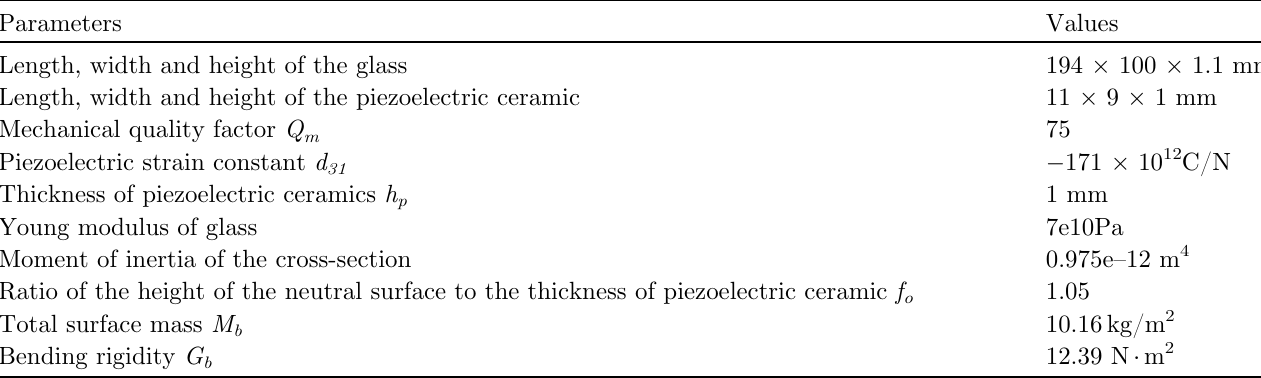
Table 1. Mechanical properties of the texture-rendering